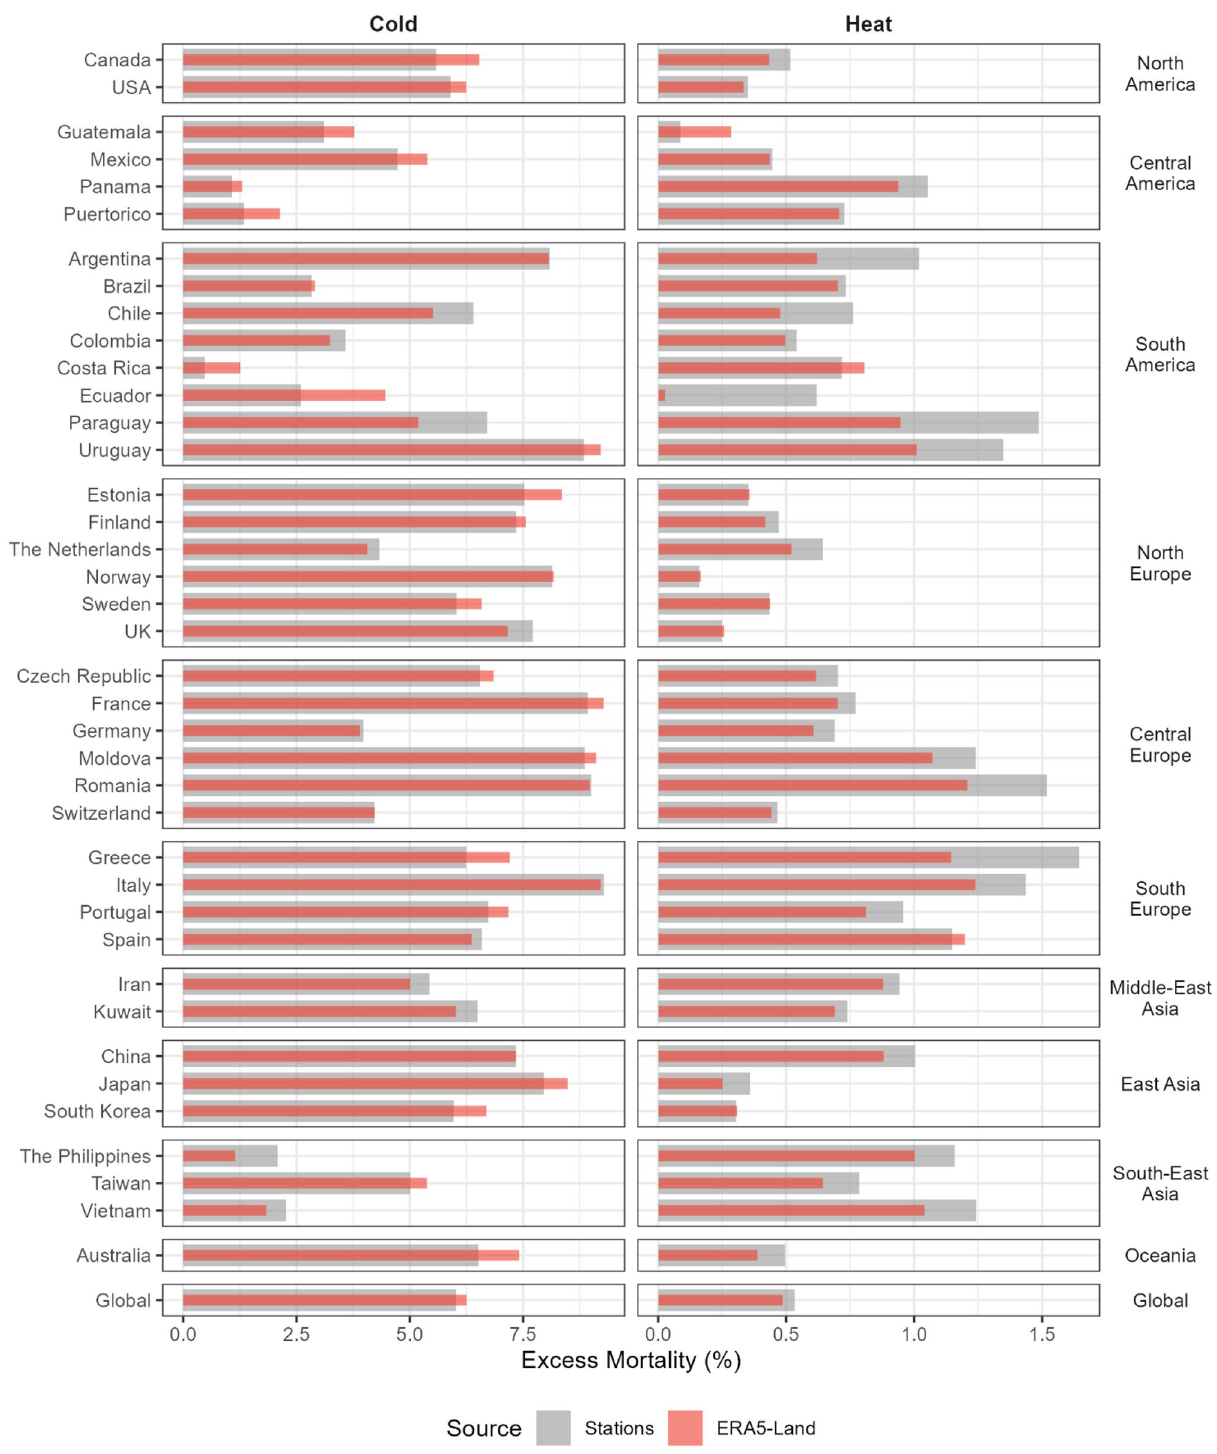
Figure 5. Fraction of all-cause excess mortality (%) due to cold and heat by countries and all 612 locations (Global) estimated using station observations (gray) and ERA5-Land (red). The bar plots represent the excess deaths. The 95% empirical confidence intervals (eCI) computed using Monte Carlo simulations (see “Methods”) are reported in Table S3 in the “Supplementary material”. The range of x-axes are different in the two